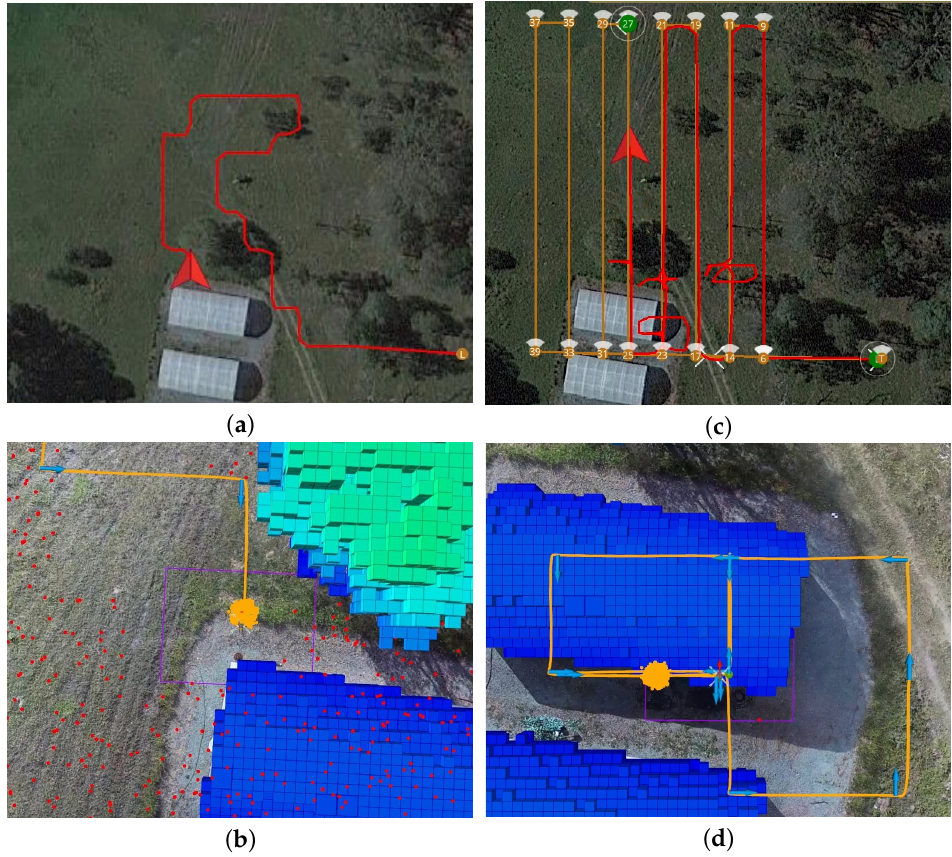
Figure 18. Illustration of two traversed paths using the proposed POMDP-based motion planner. ( a ) Traversed path of the UAV in offboard mode. ( b ) Probabilistic belief locations of the UAV (orange) and victim (red), the latter covering the entire surveyed area. ( c ) Traversed path of the UAV in hybrid mode. ( d ) Common path pattern by the UAV to confirm or discard positive detections sent by the computer vision module. Table 6. Average duration among flight modes to locate the victim. Here, M1, M2, and M3 refer to mission, offboard, and hybrid flight modes,